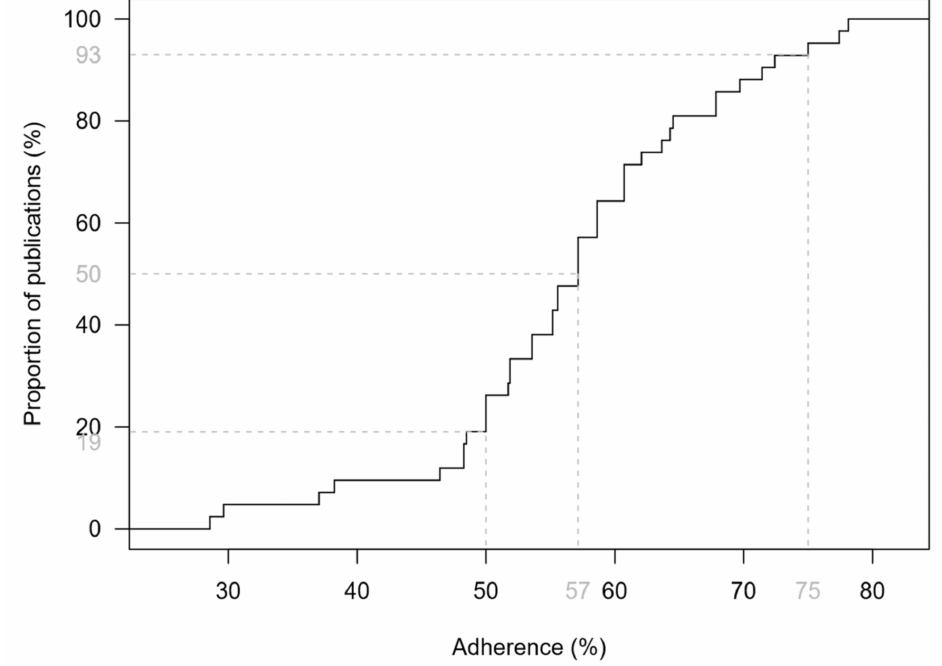
Figure 1. Empirical distribution function of the TRIPOD adherence score based on 42 studies addressing melanoma risk prediction models and their validation. Dashed lines indicate the median, as well as the proportions of studies that achieved a score of less than 50% and less than